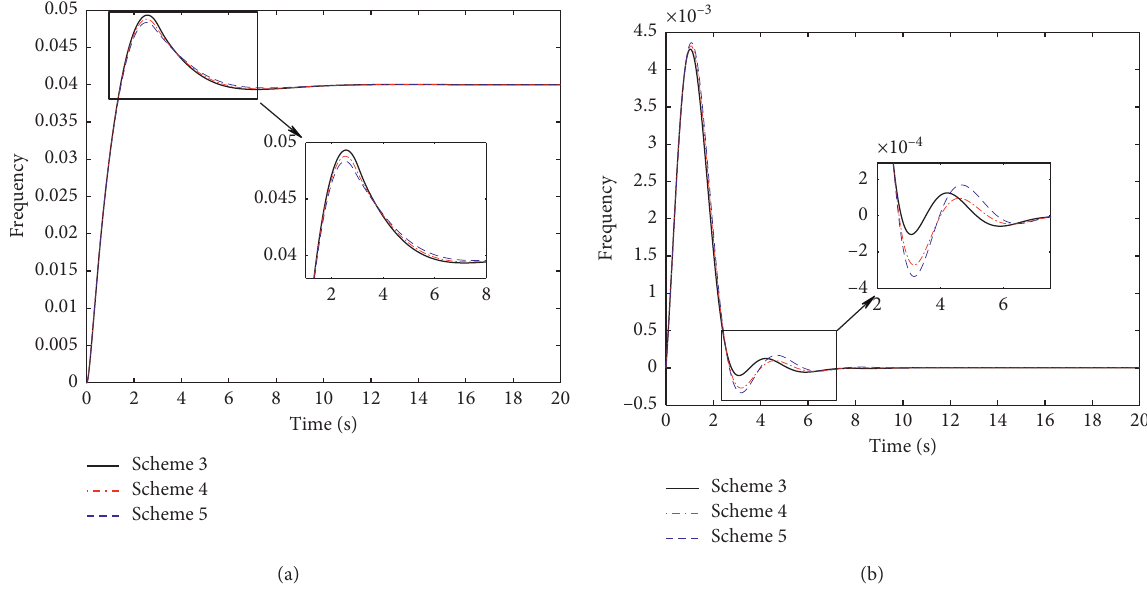
Figure 10: Transient process responses with different control schemes. (a) No-load operating condition; (b) on-load operating